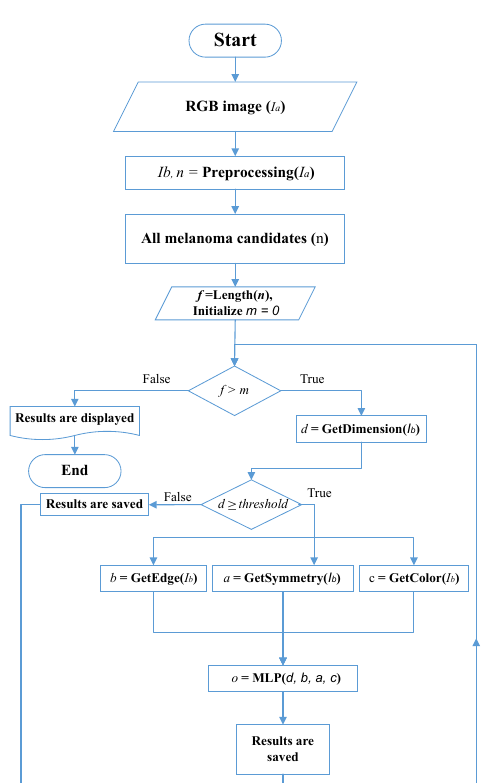
Figure 2. Flowchart of the proposed method.